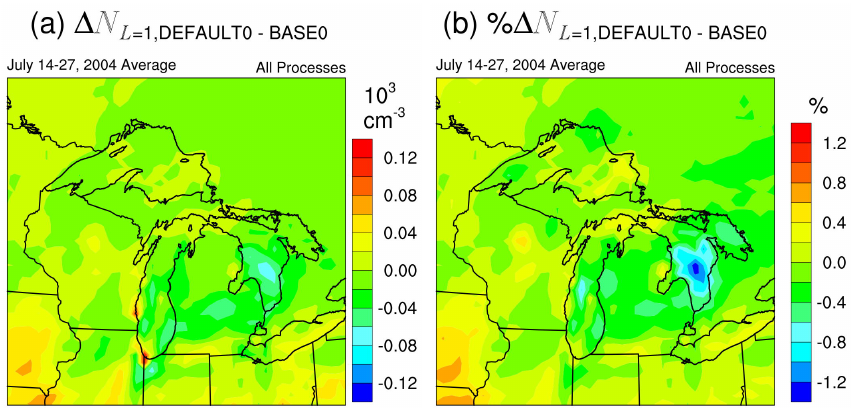
Fig. 10. (a) Difference and (b) percent difference in surface-layer aerosol number concentration between the DEFAULT0 and the BASE0 cases; results are averaged over the 14–27 July 2004